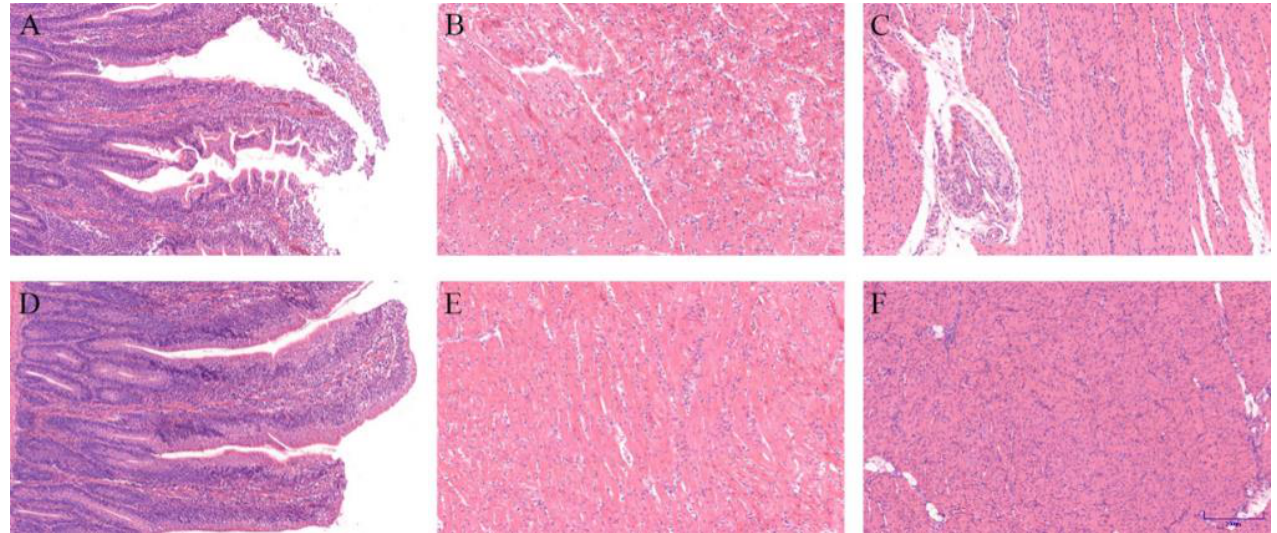
Figure 1. H&E staining tissue sections of duodenum, heart, and stomach. ( A – C ) CS group ( A ): Duodenum; ( B ): Heart; ( C ): stomach. ( D – F ) EUE group ( D ): Duodenum; ( E ): Heart; ( F ): Stomach.